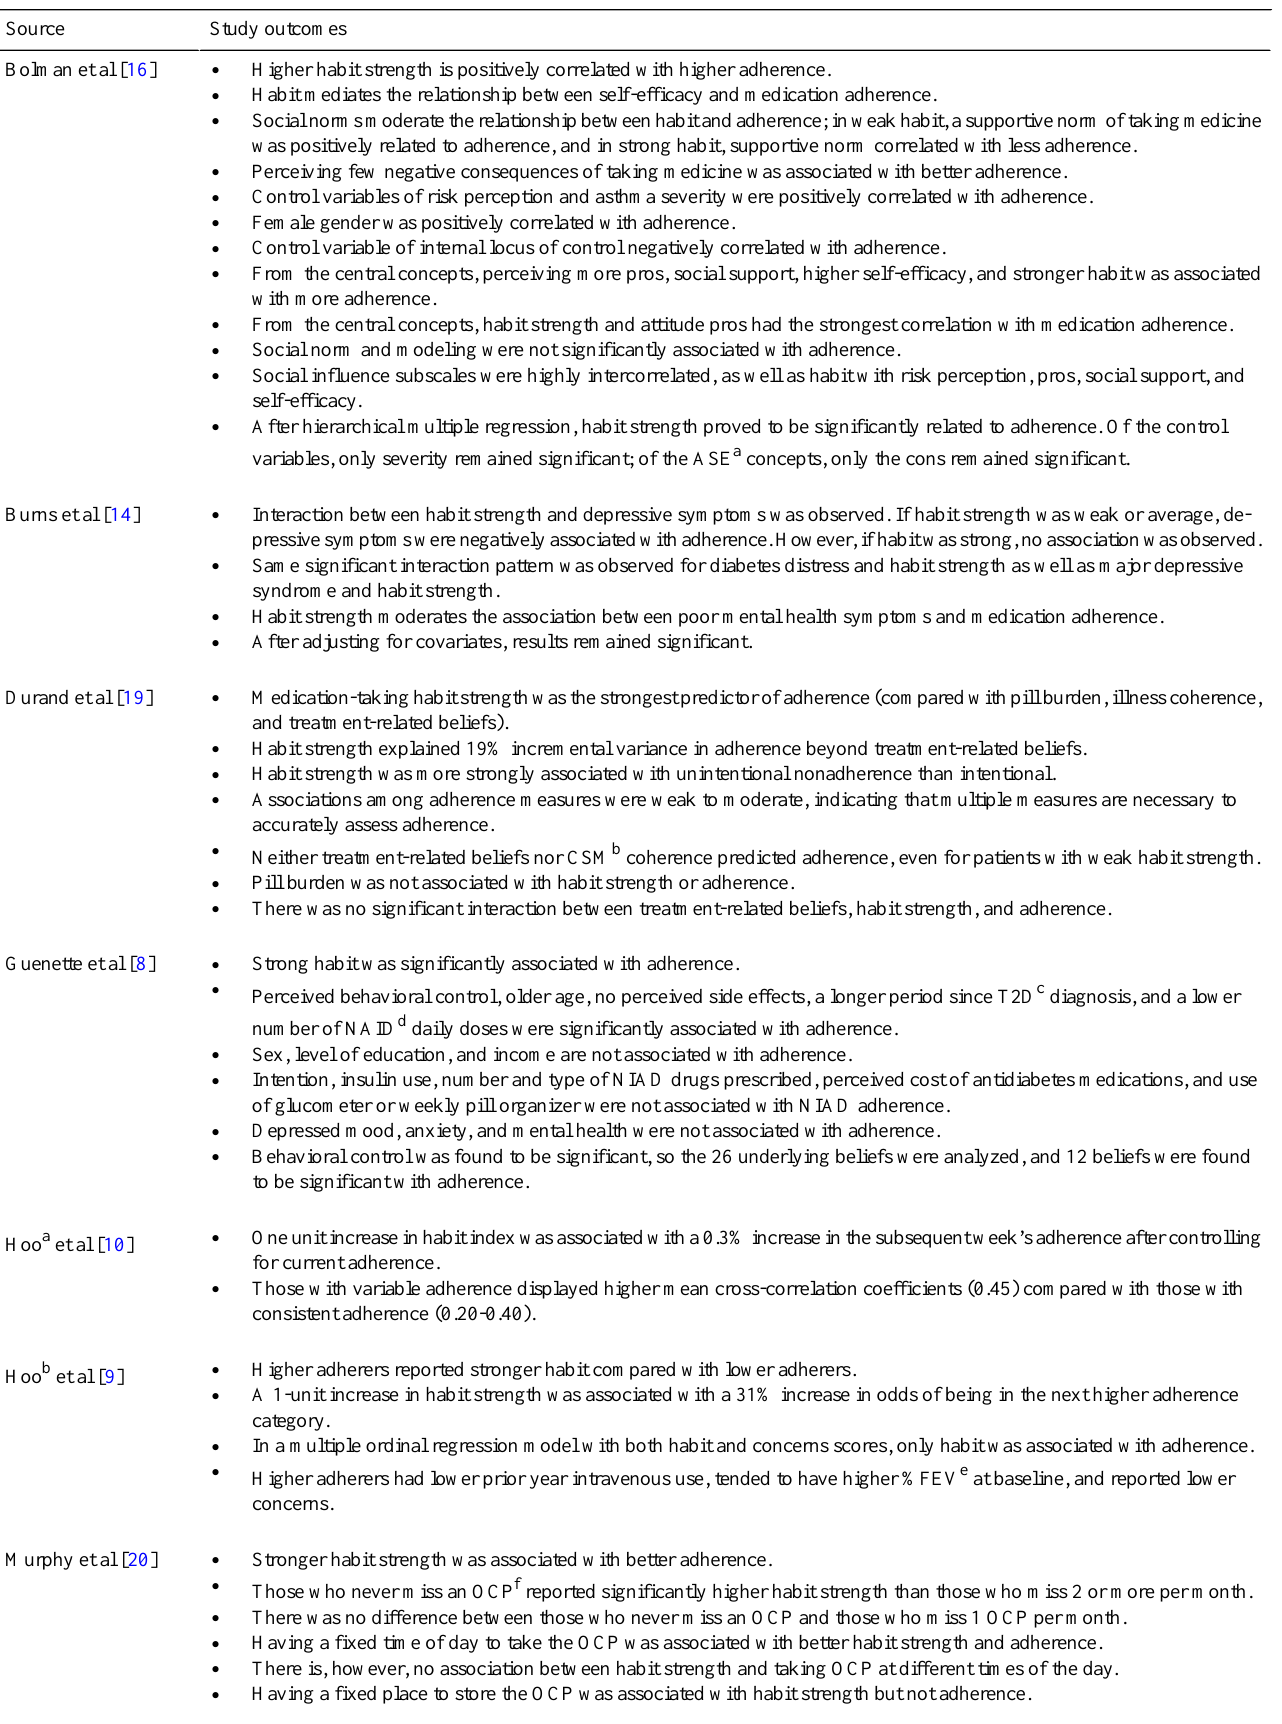
Table 3. Summary of the main study